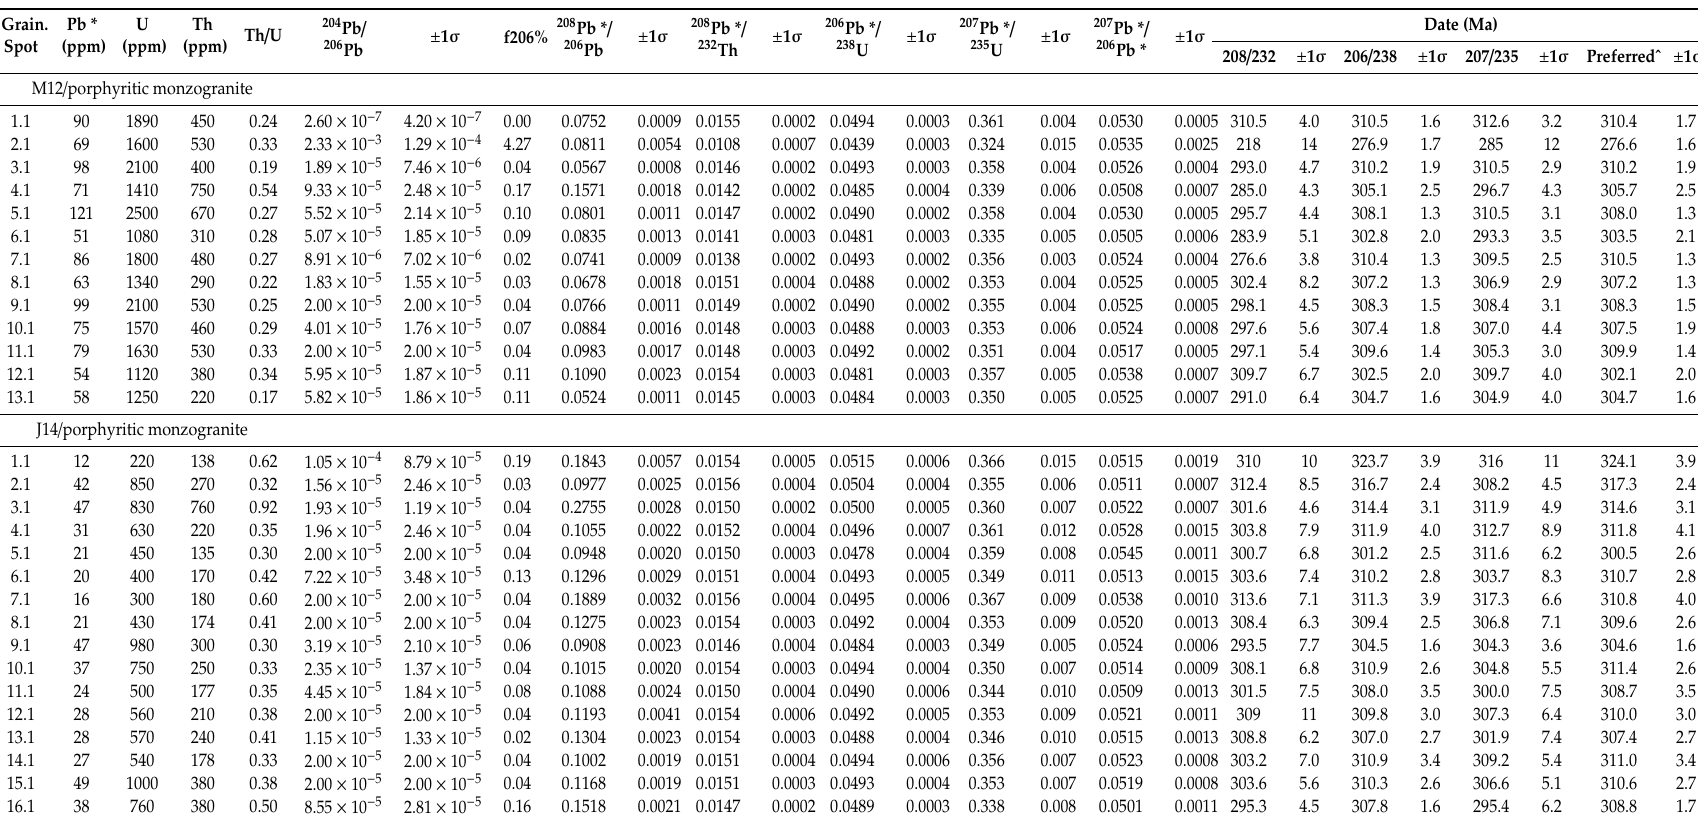
Table A3. SHRIMP data for zircons from porphyritic monzogranites from the Karkonosze Pluton and its eastern metamorphic cover. Grain.